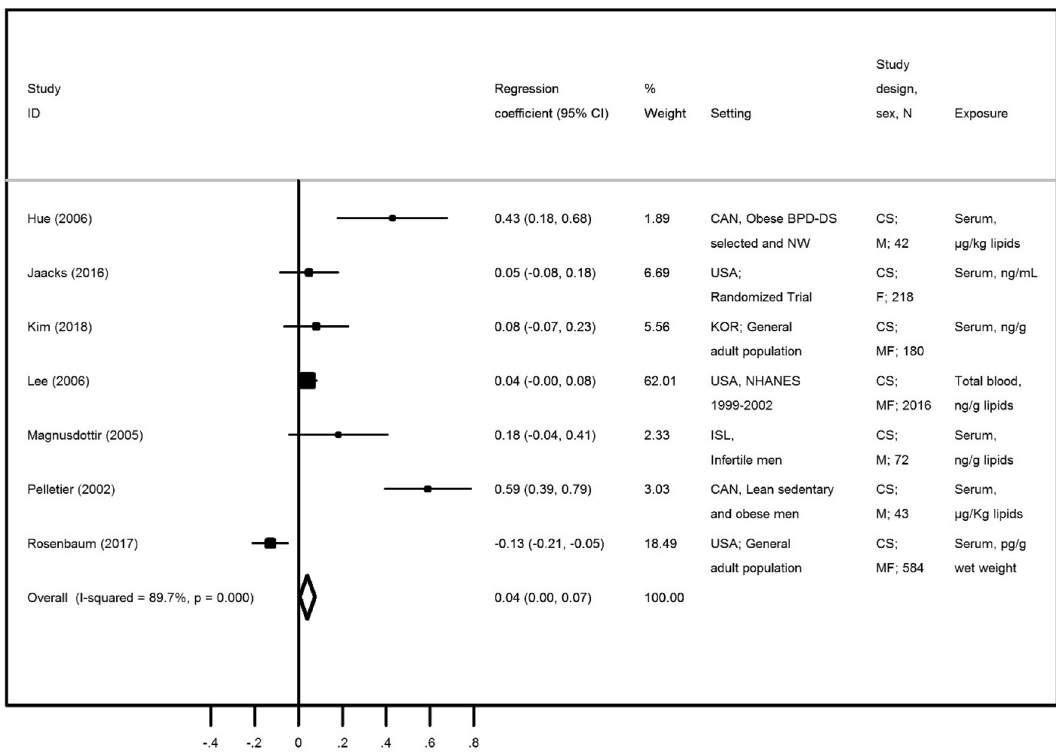
Figure 2. Meta-analysis of studies evaluating the association of oxychlordane with body mass index (BMI). Beta coefficients and corresponding 95% CI (horizontal lines). The size of the black square indicates the study’s weight in the analysis (weights are from fixed-effects analysis). The centre of the open diamond indicates the summary estimate and its width represents the 95%